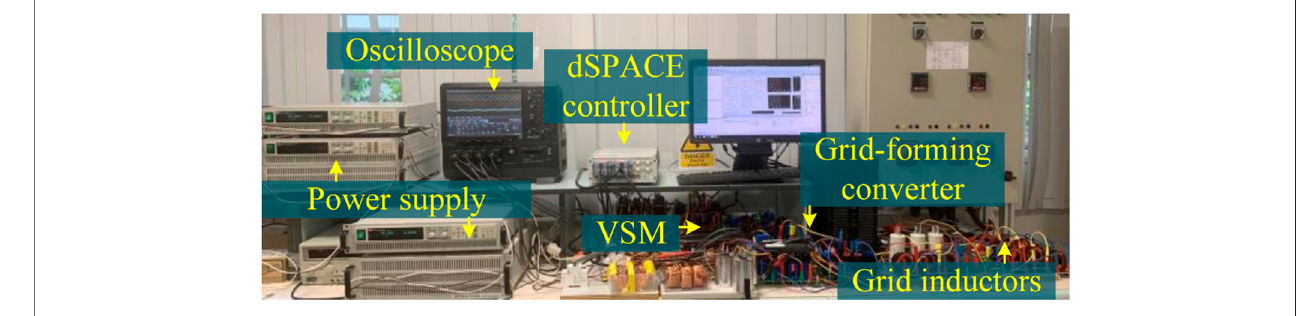
FIGURE 11 | The experimental